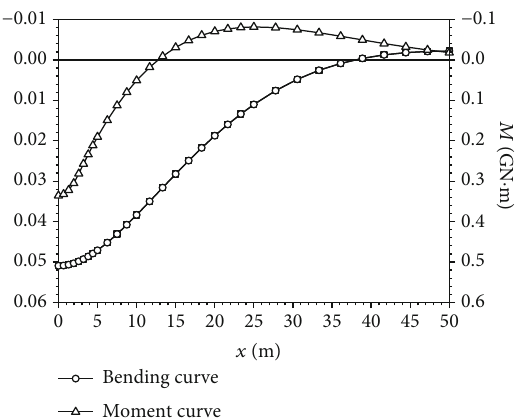
Figure 3: De fl ection and bending moment curve of composite beam.